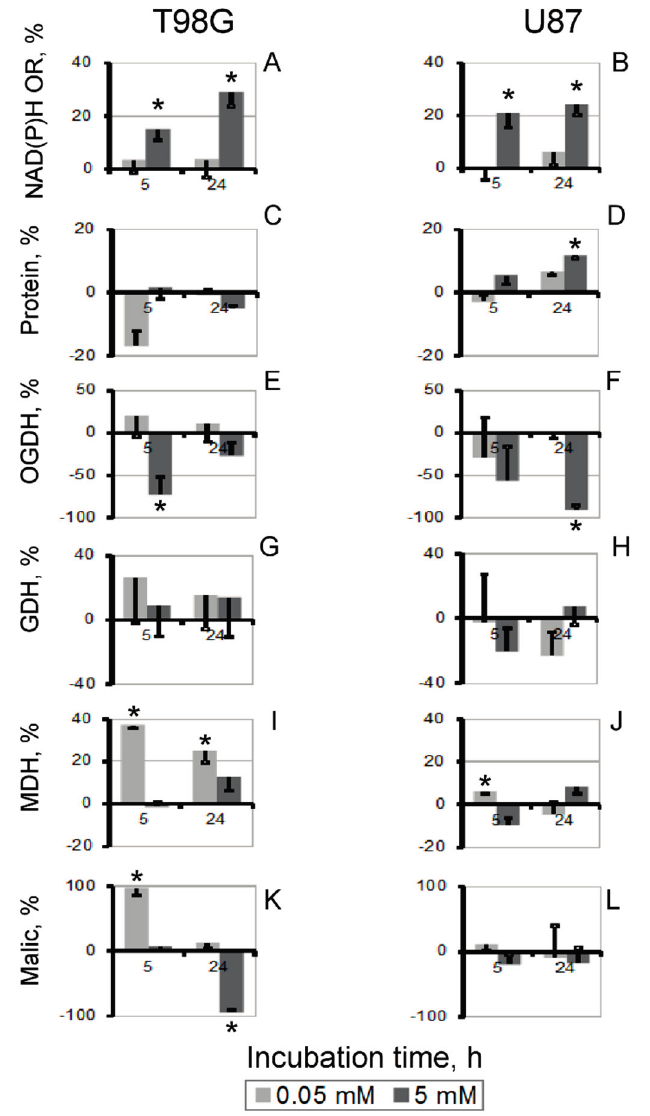
Figure 3. Differences in the thiamin and oxythiamin effects on NAD(P)H:resazurin oxidoreductase (NAD(P)H OR) ( A , B ), protein ( C , D ), and tested enzymatic activities ( E – L